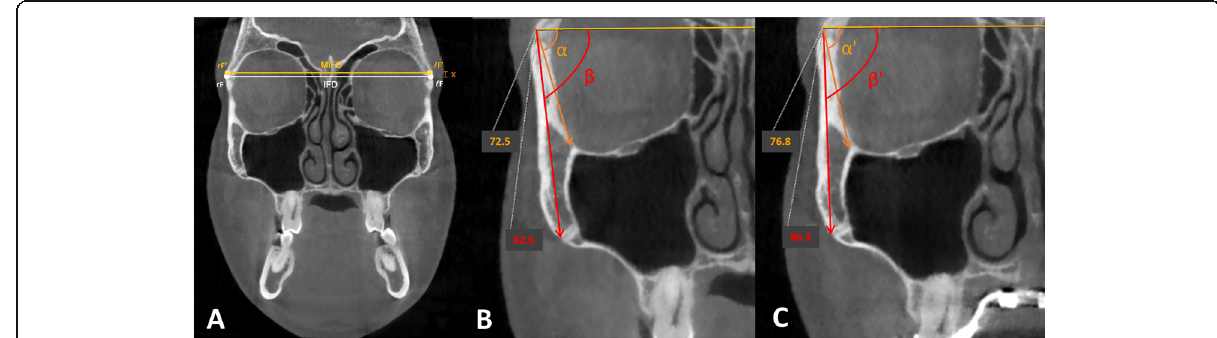
Fig. 6 a Reference lines to determine rotational fulcrum. Interfrontal distance (IFD) and modified interfrontal distance (MIFD); x , distance between IFD and MIFD. According to the Reuleaux technique, at least two corresponding landmarks must show uniform displacement around a single point, to be able to pinpoint a center of rotation. b Pre-expansion measurements. c Post-expansion measurements. By subtracting the pre- expansion values from the post-expansion values ( α ’ − α = β ’ − β ), equals 4.3° of difference